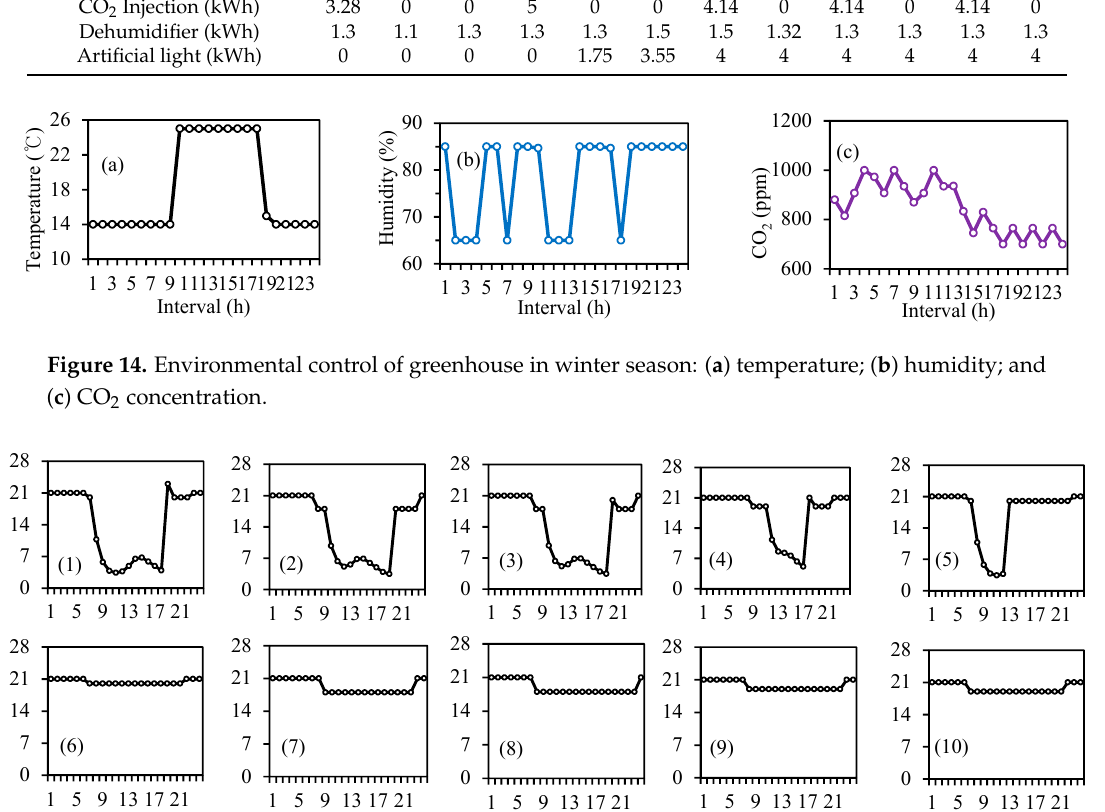
Figure 15. Temperature control of each household during winter season in building ( X -axis: interval (h), Y -axis: temperature (°C)).